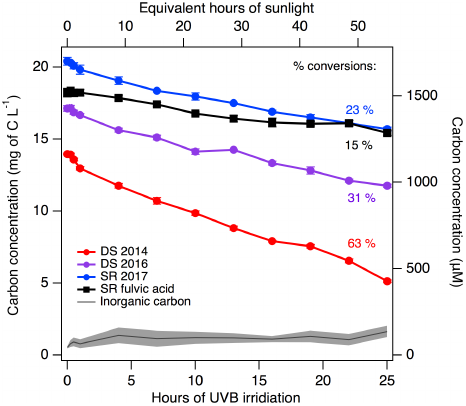
Figure 5. CCN abilities and IN abilities of DOM as a function of organic carbon. Slopes for κ vs. organic carbon are all y = − 0 . 02 x . However, the slopes for T 50 vs. organic carbon are different for dif- ferent DOM: 0.17, 0.66, 0.34 and 0.81 for DS 2014, DS 2016, SR 2017 and SRFA, respectively.